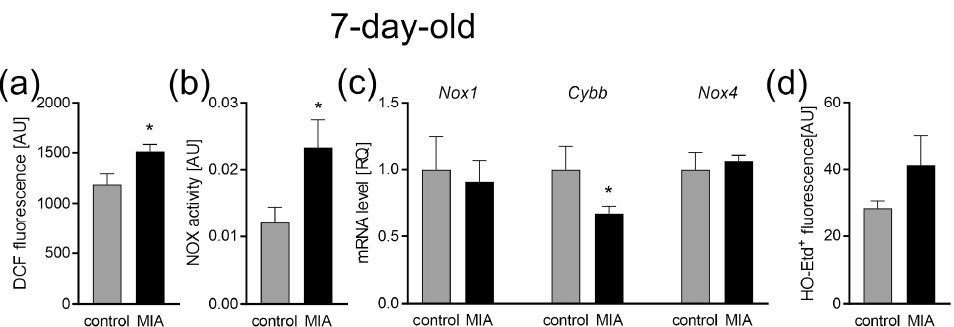
Figure 3. The effect of MIA on oxidative stress in the brain of 7-day-old offspring. ( a ) The level of reactive oxygen species was determined with a DCFH-DA probe (n = 8). ( b ) The level of NADPH oxidase (NOX) activity (n = 7 and 8). ( c ) The mRNA levels of NOX subunits Nox1 , Cybb , and Nox4 were determined using a real-time PCR method with Actb ( β -actin) as a reference gene (n = 5 and 6). ( d ) The generation of superoxide radicals was determined by the fluorimetric method using DHE (n = 4). Data represent the mean value ± S.E.M. and were analysed using Student’s t -test, * p < 0.05, compared with the control group.